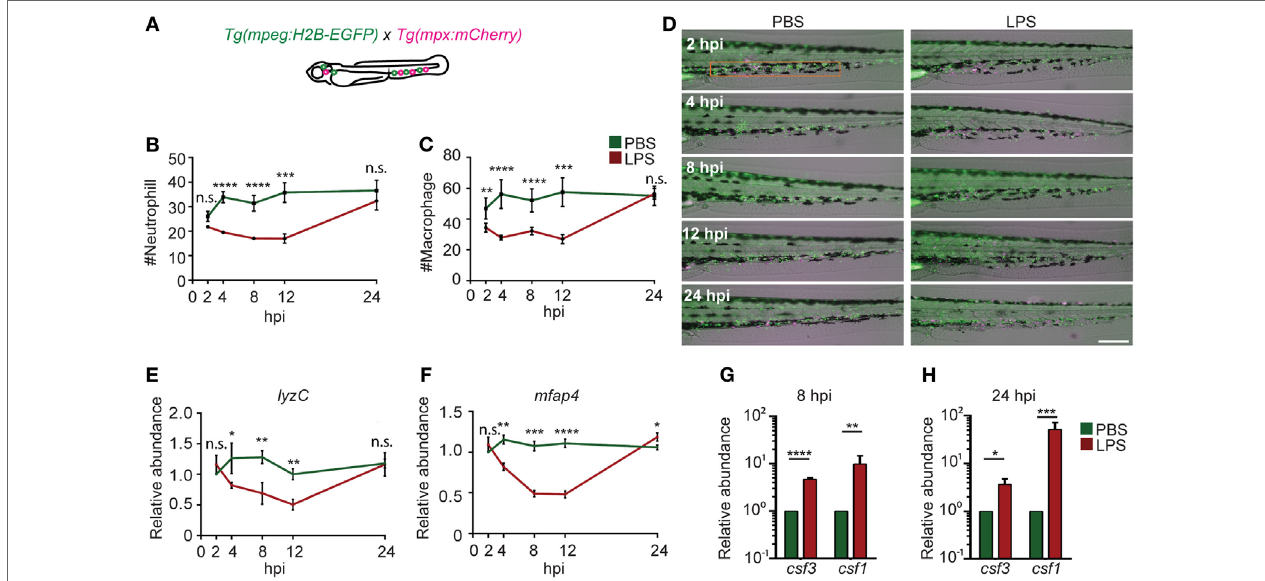
FigUre 4 | Immune cell mobilization and emergency hematopoiesis induced with lipopolysaccharide (LPS) injection. (a) . Tg(mpeg:H2B-GFP) fish were crossed with Tg(mpx:mCherry) label macrophages (green) and neutrophils (red). The quantification of neutrophil (B) and macrophage (c) numbers and representative images (D) in the caudal hematopoietic tissue (CHT) (orange box) after PBS or LPS injection. Images representative of three independent experiments were shown ( n = 20). Scale bar: 200 µm. (e,F) mRNA level of lyzC (e) and mfap4 (F) in the whole larvae injected with PBS or LPS. Results were normalized with ef1 α and are presented as means ± SD (D) ( n = 3 independent experiments with over 20 larvae each/experiment). * p < 0.05, ** p < 0.01, *** p < 0.001, **** p < 0.0001, Mann–Whitney test. (g,h) mRNA level of csf3 and csf1 in whole larvae injected with PBS or LPS at 8 hpi (g) and 24 hpi (h) . Results were normalized with ef1 α and are presented as means ± SD ( n = 3 biological repeats with 20 larvae in each group). * p < 0.05, ** p < 0.01, *** p < 0.001, **** p < 0.0001, Mann–Whitney